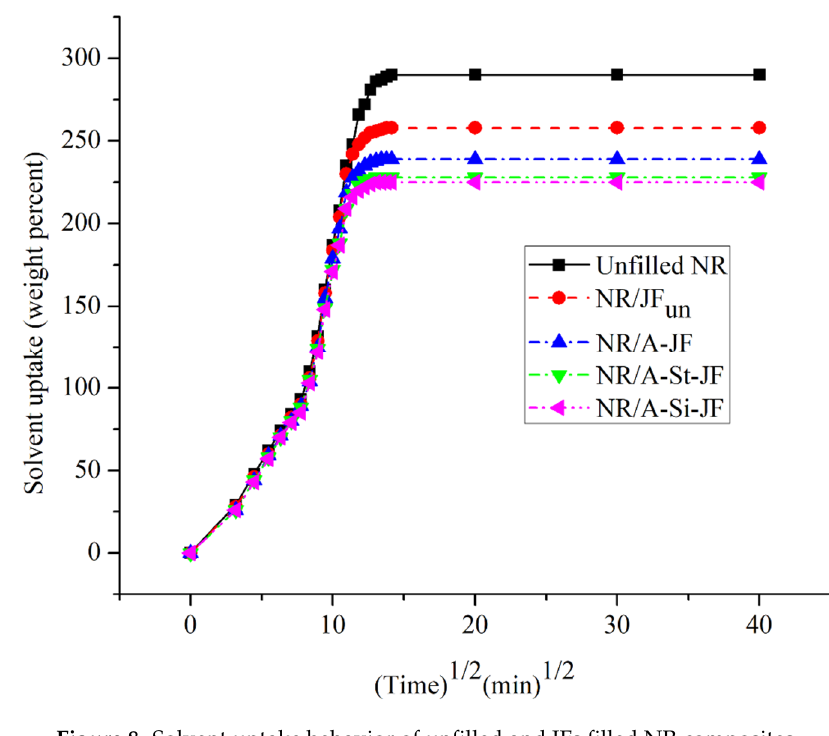
Figure 8. Solvent uptake behavior of unfilled and JFs filled NR composites.